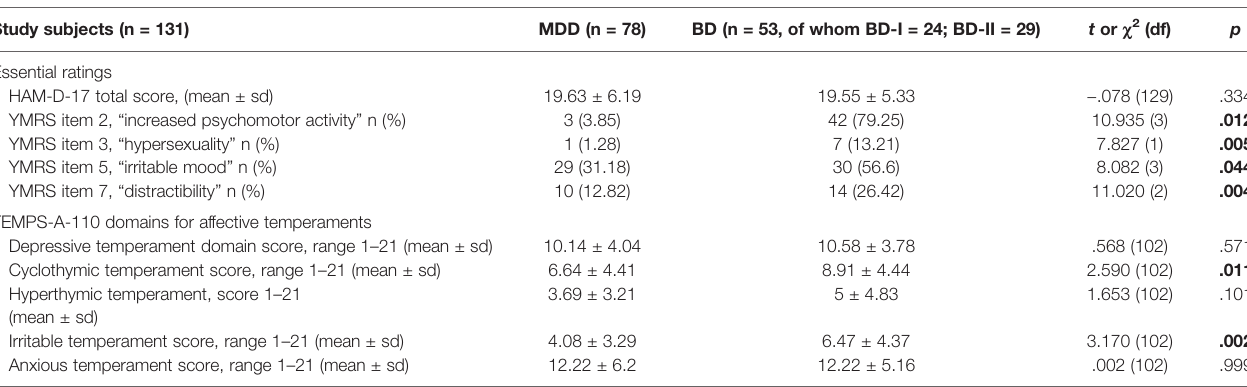
TABLE 3 | Rating and temperamental pro fi le of MDD and BD patients. Study subjects (n = 131) MDD (n =